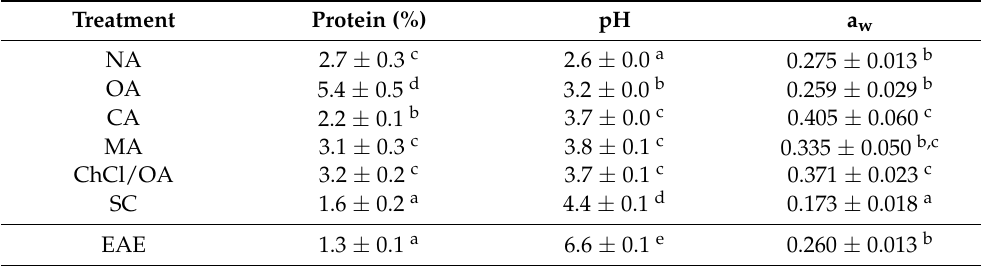
Table 1. Physicochemical characterization of grape pomace (GP) pectins extracted using different methodologies. NA (Nitric Acid), OA (Oxalic Acid), CA (Citric Acid), MA (Malic Acid), ChCl/OA (DES Choline Chloride/Oxalic Acid), SC (Sodium Citrate), and EAE (enzymatic assisted